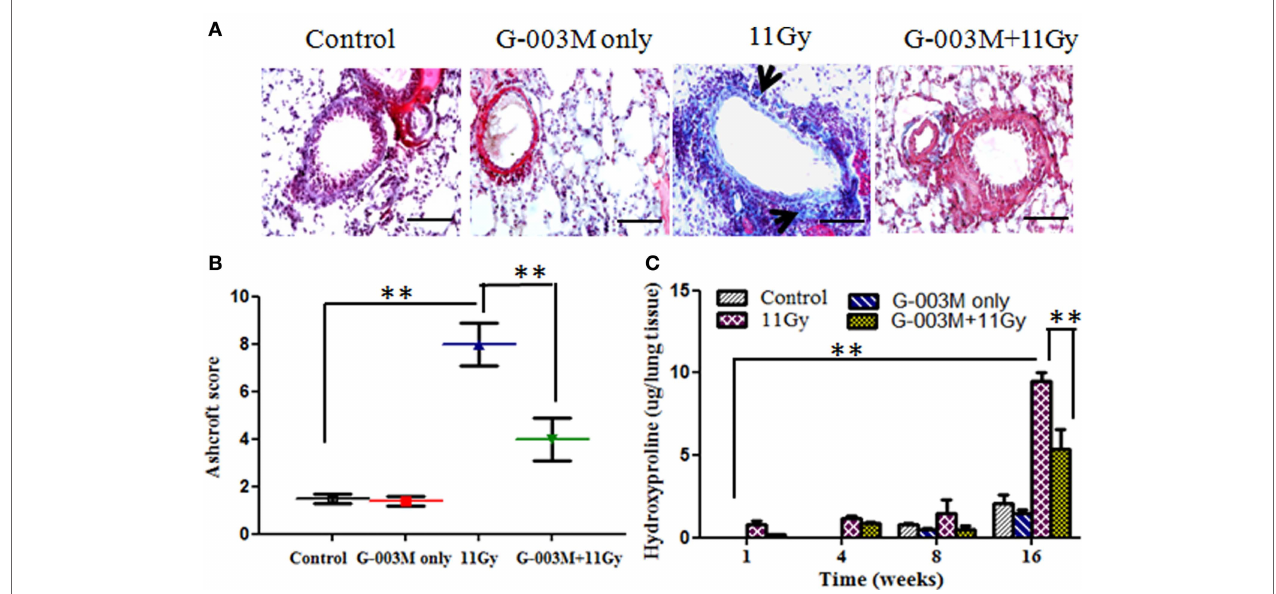
FigUre 7 | Effect of G-003M on radiation-induced fibrosis in 11 Gy thoracic-irradiated mice. (a) Photomicrographs of Masson’s trichrome-stained lung sections from differentially treated experimental groups at 16 weeks posttreatment. No significant fibrosis was found in the lungs of control and G-003M only treatment groups. About 11 Gy thoracic-irradiated lungs sections showed intense collagen fibers dyed blue (arrows). Compared to irradiated group, collagen deposition/ fibrosis was significantly less in G-003M-pretreated irradiated group. Magnification 400 × . (B) Evaluation of lung fibrosis by Ashcroft score at 16 weeks posttreatment. (c) Quantitative analysis of hydroxyproline content in lungs of experimental mice. Scale bar 50 µm. Data are represented as means ± SEM from six mice for each group. ** p <